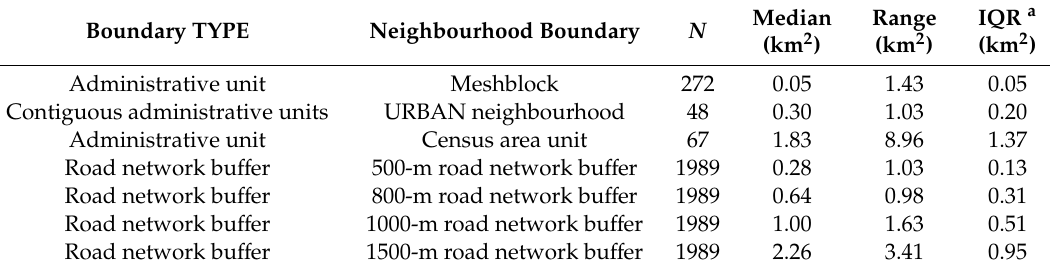
Table 3. Neighbourhood boundary size descriptive